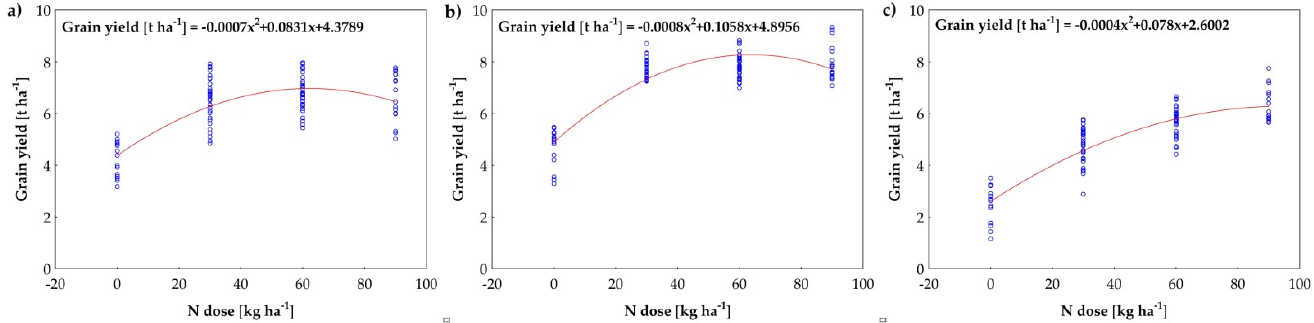
Figure 1. The effect of different N doses on spring barley grain yield (t ha − 1 ) in ( a ) Caslav, ( b ) Ivanovice, ( c ) Lukavec. The data is interpolated by a quadratic model (red line).